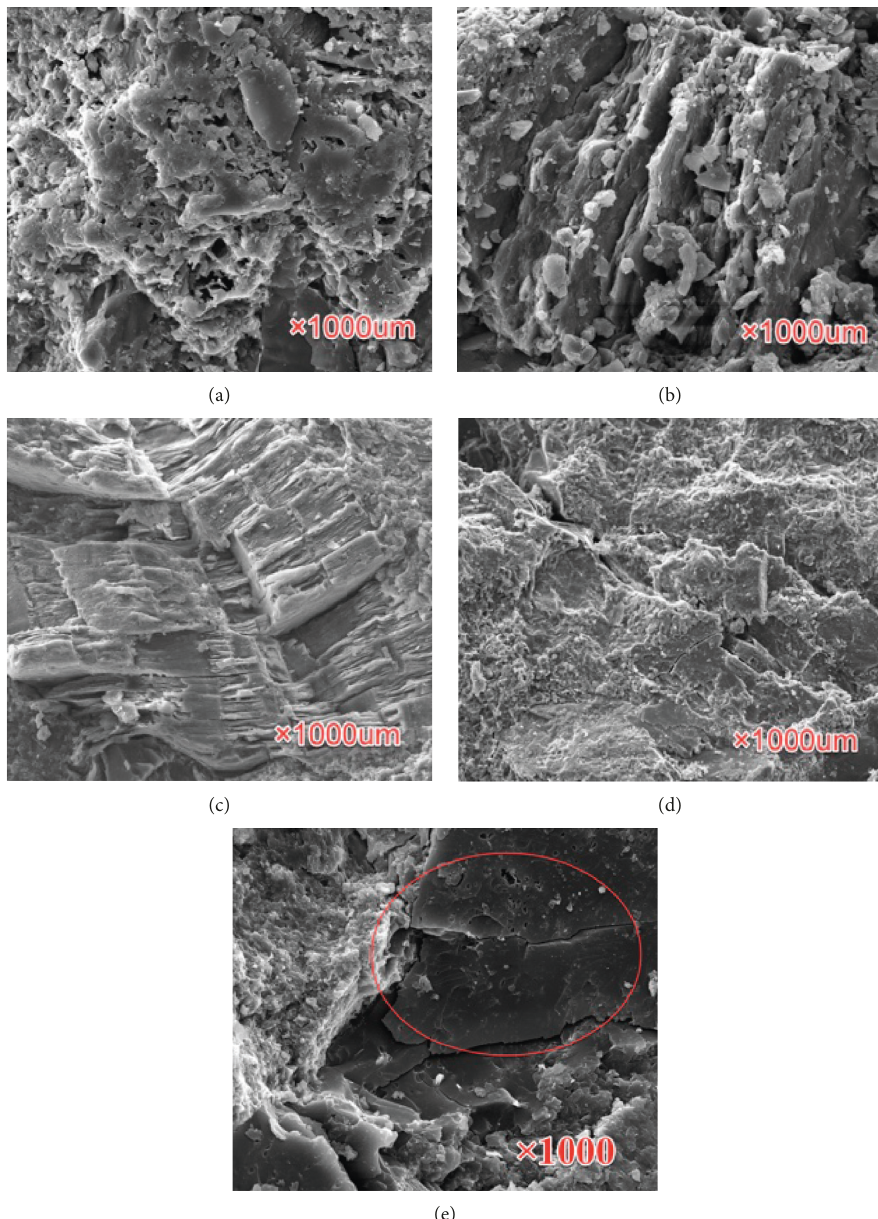
Figure 7: The morphologies of the fracture section. (a) Honeycomb-like microstructure, (b) striped microstructure, (c) step-like mi- crostructure, (d) flocculent microstructure, and (e) smooth-joint